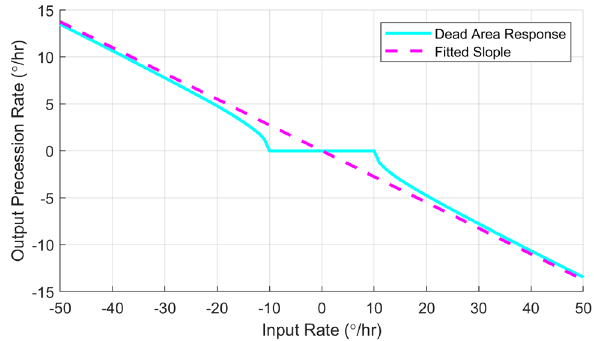
Figure 6. The dead-zone effect of HRG with damping mismatch.